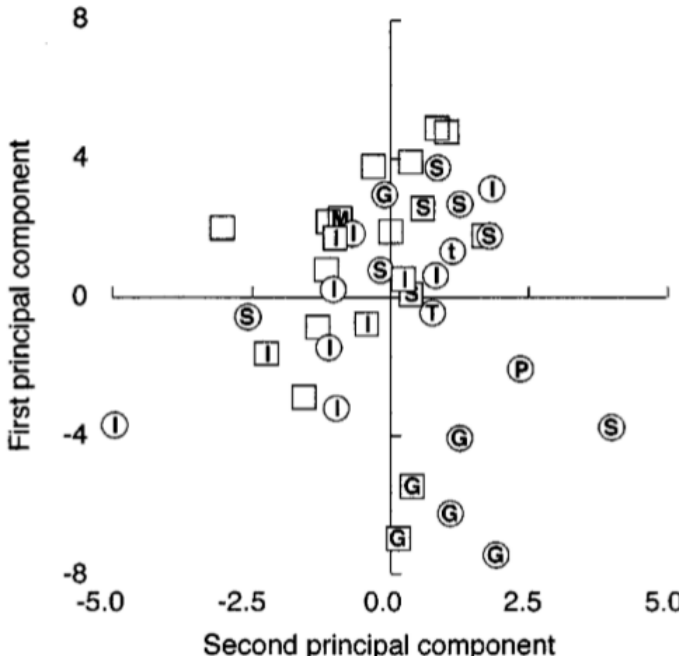
Figure 4. PCA results of the n-alkanes ( n -C 15 - n -C 35 ) in authentic ( ○ ) and commercial ( □ ) extra olive oils. By plotting the first principal component against the second principal component, the Greek oil (G) is shown to be well resolved from Spanish (S) and Italian (I) oils. Reference [5] with permission from The Royal Society of Chemistry.